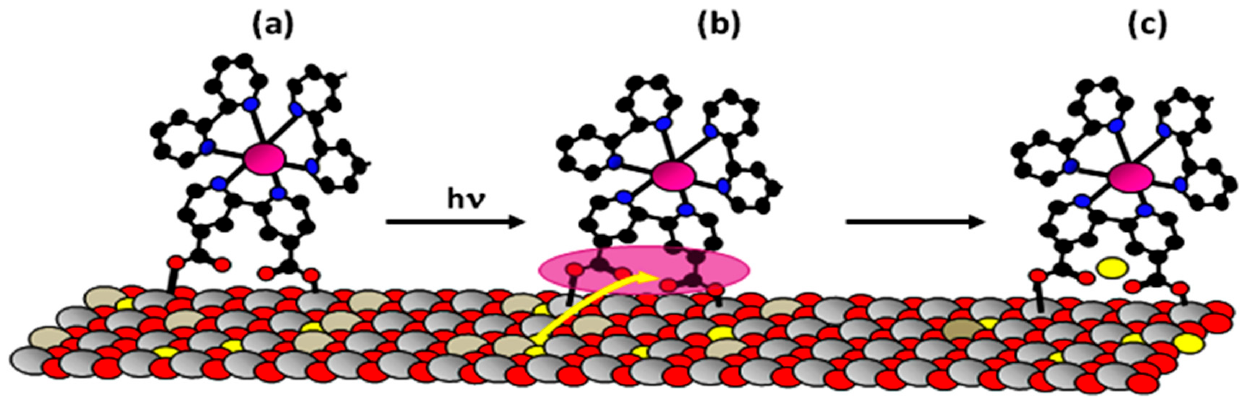
Figure 30. Scheme showing the photochemical generation of the meta-stable lithium adduct. ( a ) Ground state, the ruthenium dye is bound to the surface of TiO 2 ( b ) the excited dye acts as photo-base and captures a Li + ion from its neighborhood. ( c ) After deactivation, a Li–dye adduct is formed. Atom color legend: White (Ti), red (O), yellow (Li), black (C), blue (N), and pink (Ru).